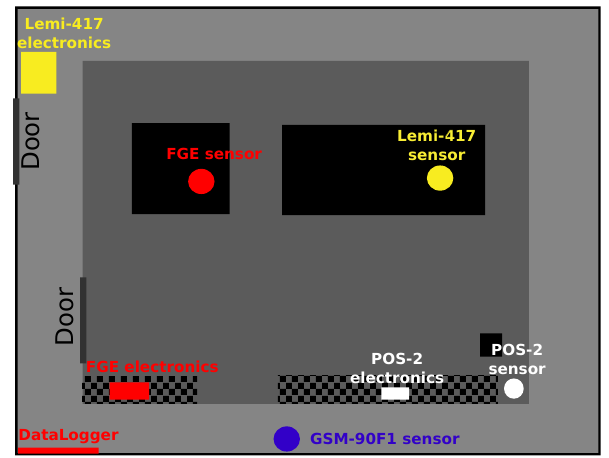
Figure 5. Schematics of the variometer house. The insulated inner room is shown in dark grey. Further, the equipment that has been installed prior to 2015 is shown in white (removed 2015) and yel- low (in operation after 2015), the equipment installed in 2015 is shown in red, and the equipment installed in 2016 is shown in blue. Black areas refer to solid stone pillars in the variometer house, black checked areas refer to shelves, and doors are shown in black as well.